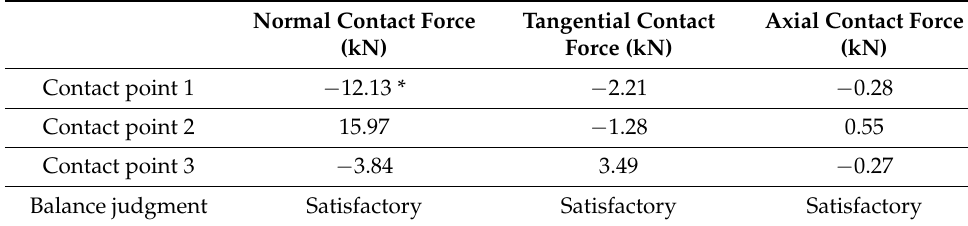
Table 3. Contact forces of cage at the time 1.51 s.